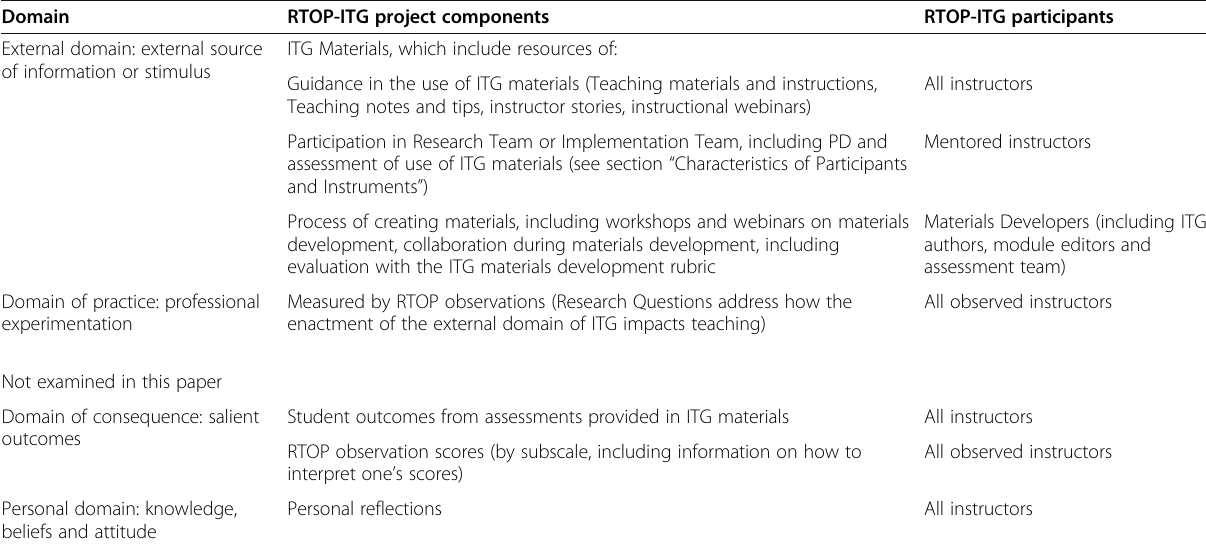
Table 1 A summary of components of the RTOP-ITG project considered in this paper (white rows) that can support a change in teaching (Clarke & Hollingsworth, 2002) when instructors use ITG. Additional supports outside of the ITG project are also possible, but are not known for individual instructors as part of this study and are the topic of future work (grey